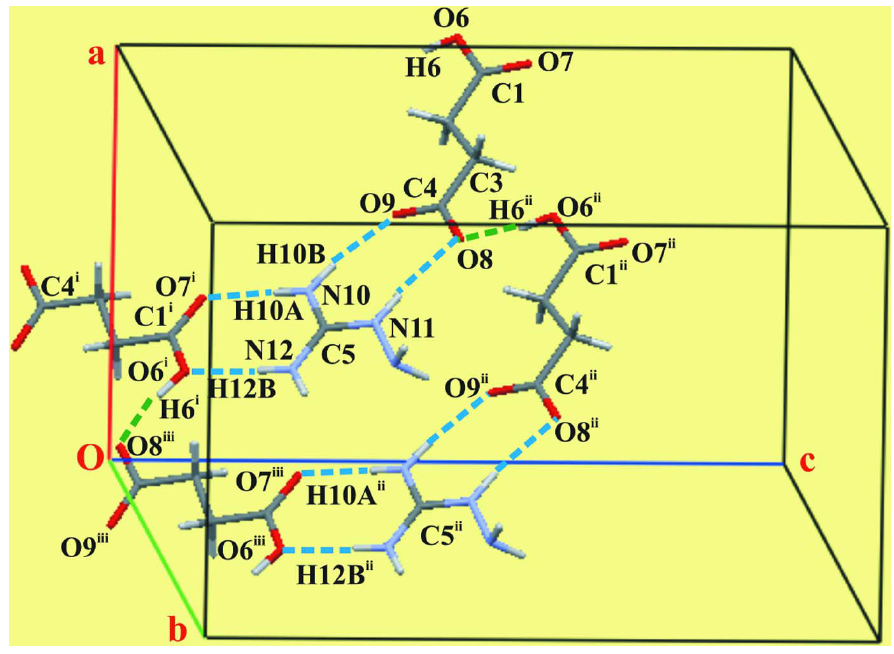
Figure 2 N—H···O and O—H···O hydrogen bonds (dotted lines) in the title compound. [Symmetry code: (i) x - 1/2, - y + 1/2, z - 1/2; (ii) x , y - 1, z